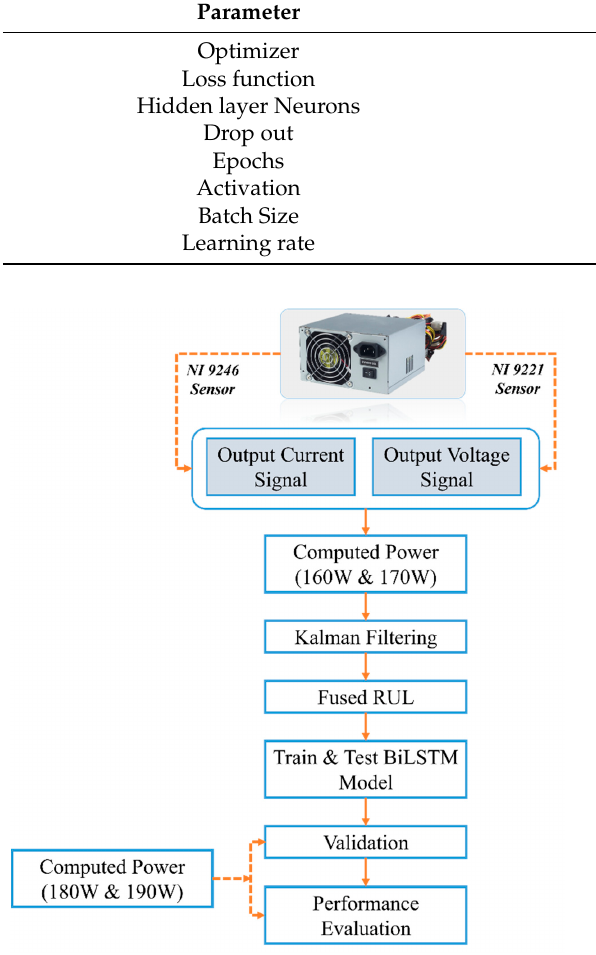
Figure 4. Proposed Prognostic Model. Table 1. BiLSTM Model Parameters.